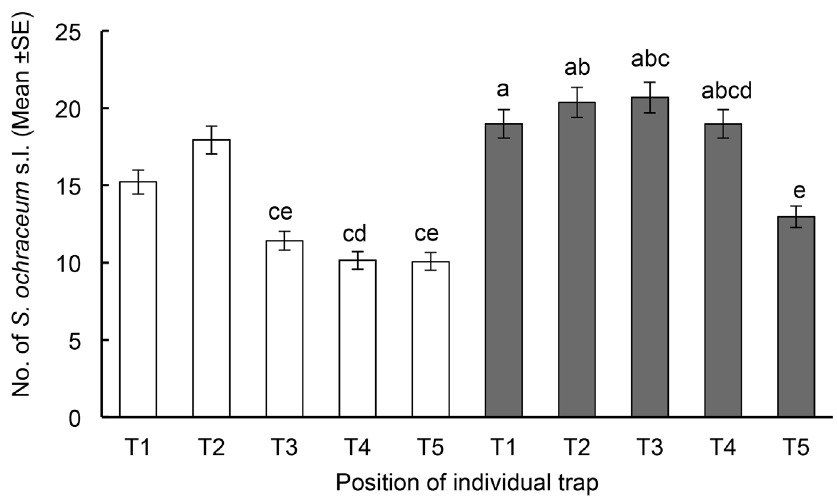
Figure 4. Mean ( ± Standard Error) of the number of flies caught by the five individual traps in coffee plantation (bars in white) and village (bars in grey). Collections among the traps at each site were compared in a pairwise fashion and the statistical significance of differences between the paired trap collections assessed using a t-test. Means with the same letter were not significantly different (p . 0.05).